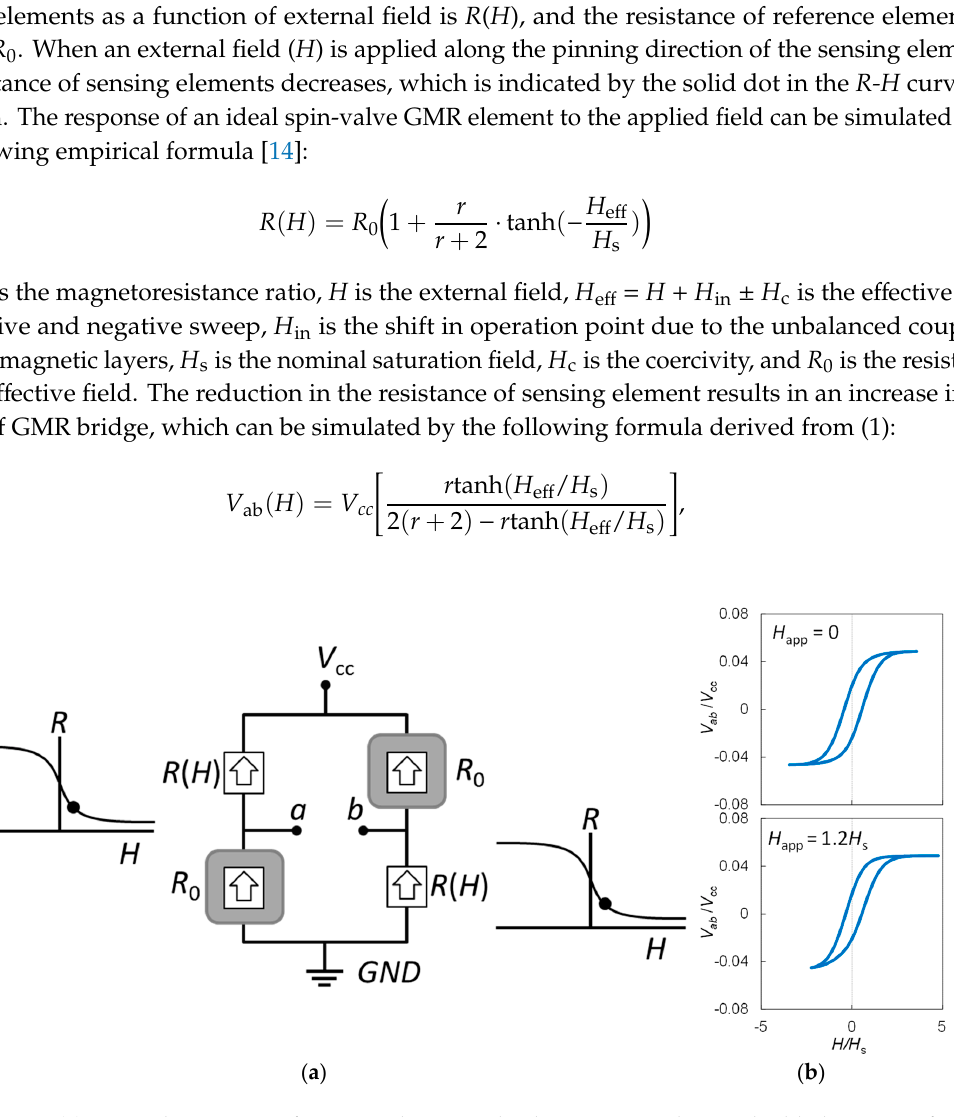
Figure 2. ( a ) Equivalent circuit of a spin-valve GMR bridge sensor with two shielded resistors for reference. ( b ) Voltage-field ( V - H ) curves of a GMR sensor simulated by using Equations (1) and (2) with and without an applied magnetic field.